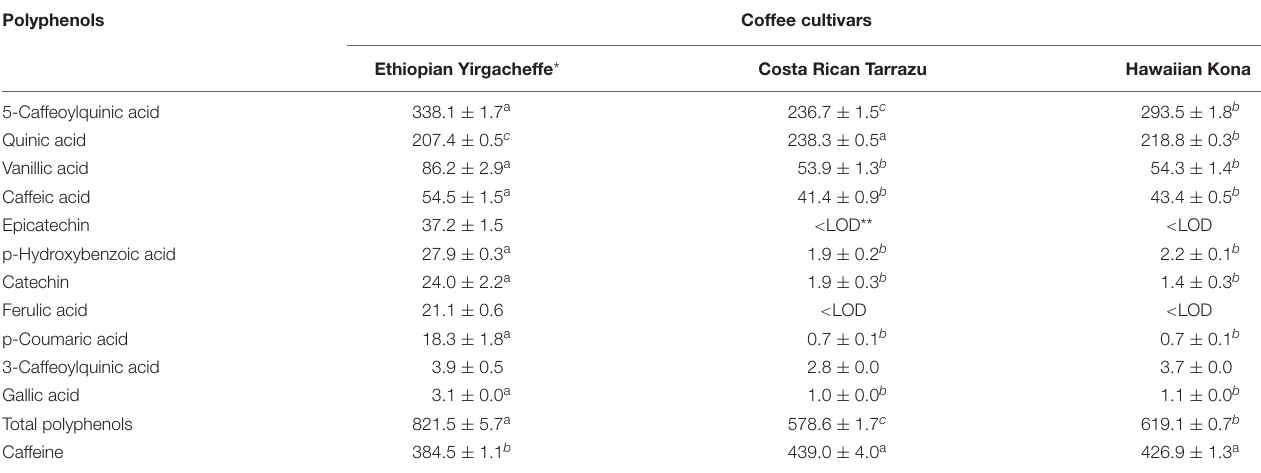
TABLE 3 | Polyphenols and caffeine (LC-MS/MS) contents ( µ g/g of dry weight) in spent coffee